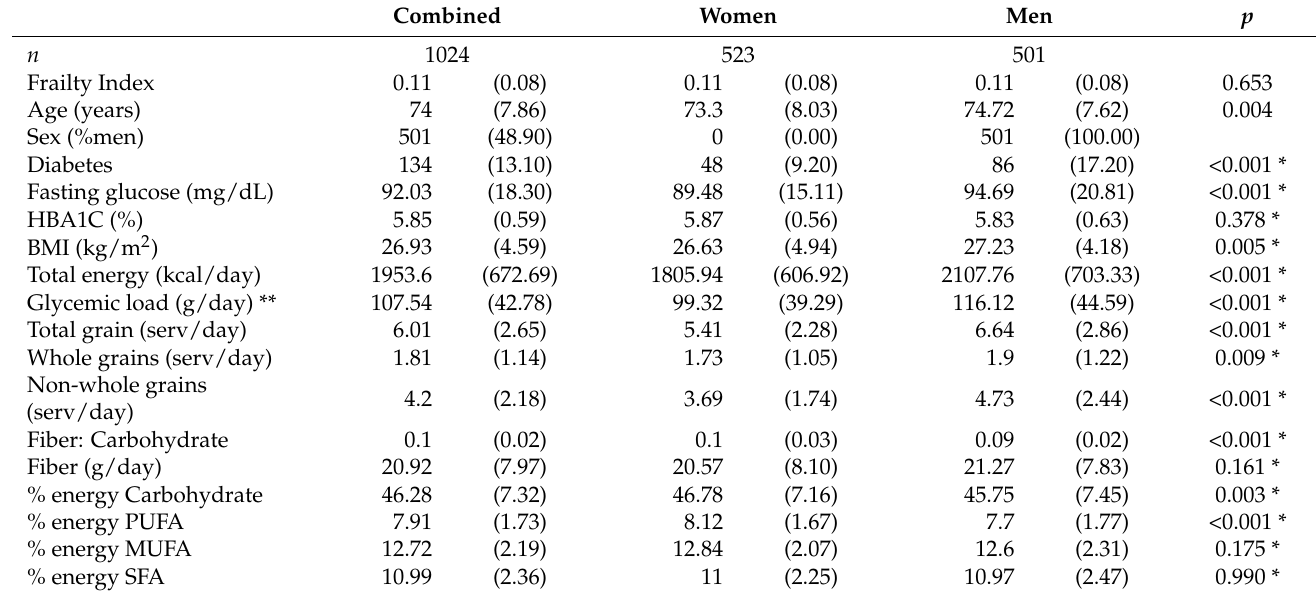
Table 1. Descriptive characteristics of the Baltimore Longitudinal Study of Aging.